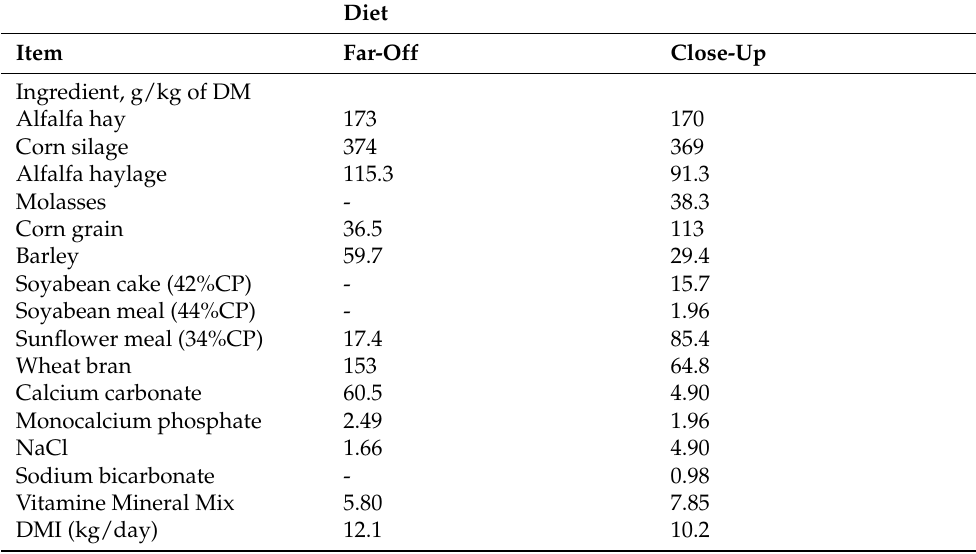
Table 1. Ingredients and chemical composition of the far-off and close-up diets.